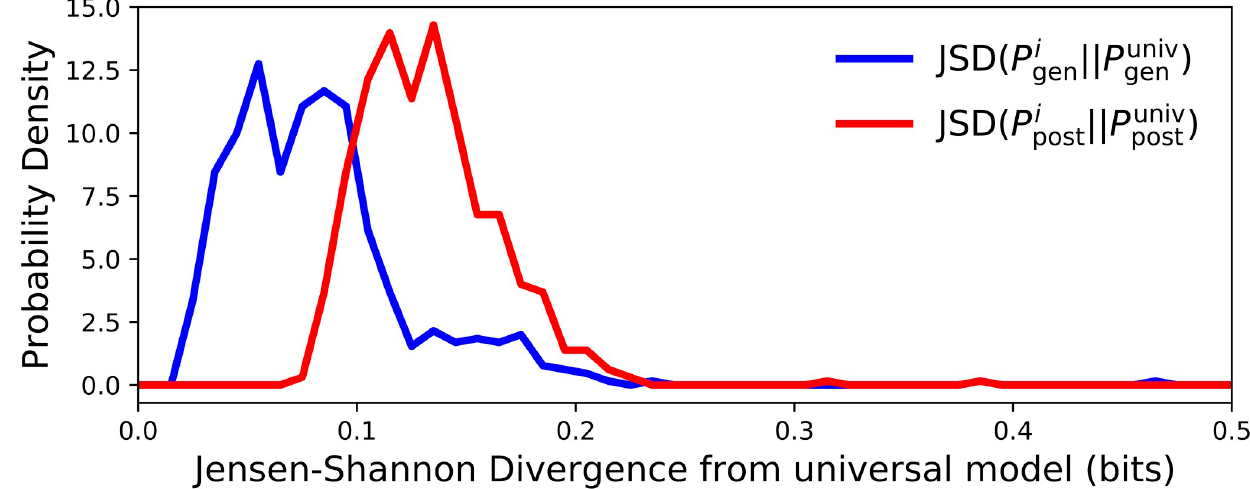
Fig 7. Normalized distributions of the Jensen-Shannon divergence (JSD) of each individual from the universal model for both P gen and P post .